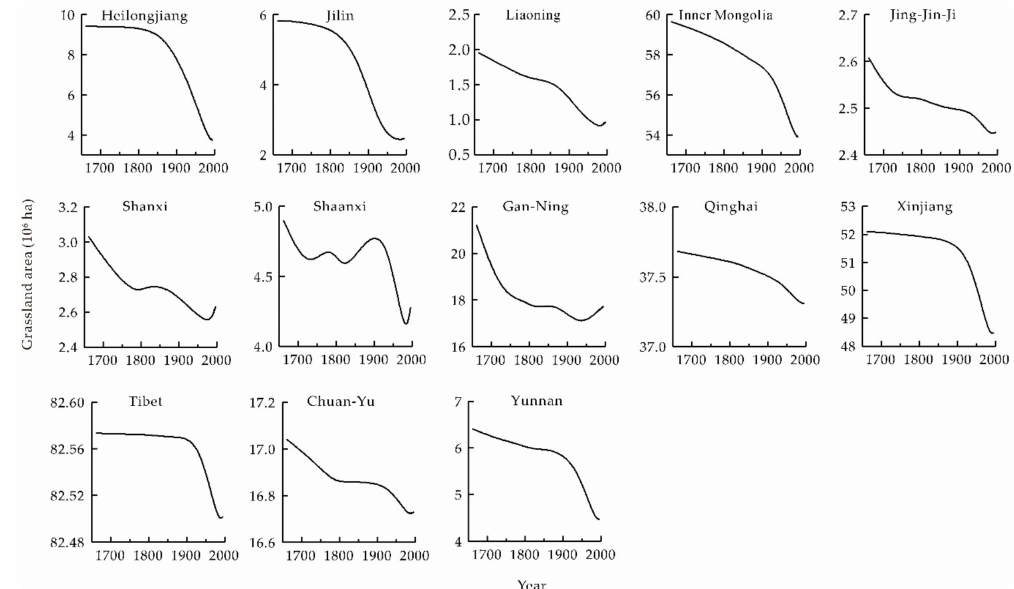
Figure 5. Changes in provincial grassland area across western China between 1661 and 1996. Data curves were smoothed using B-spline